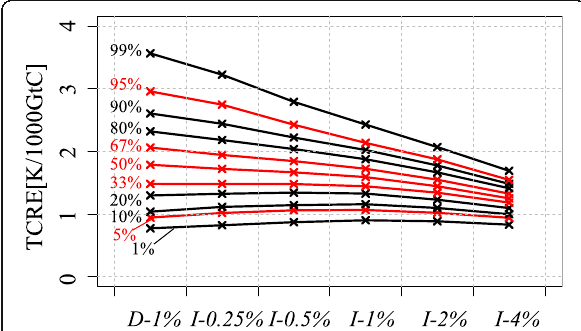
Fig. 4 Weighted values of the 1 st – 99 th percentiles of the TCRE under each scenario. D - 1 % scenario starts from a non-equilibrium